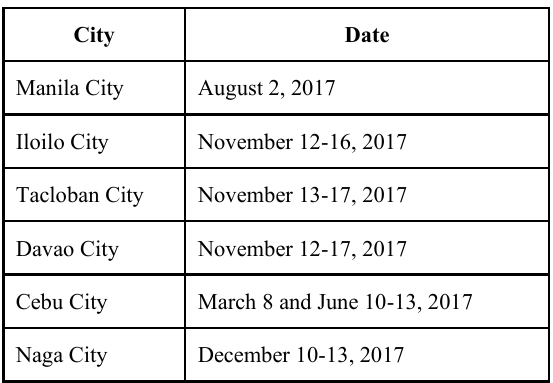
Table 1. List of cities visited and their corresponding fieldwork